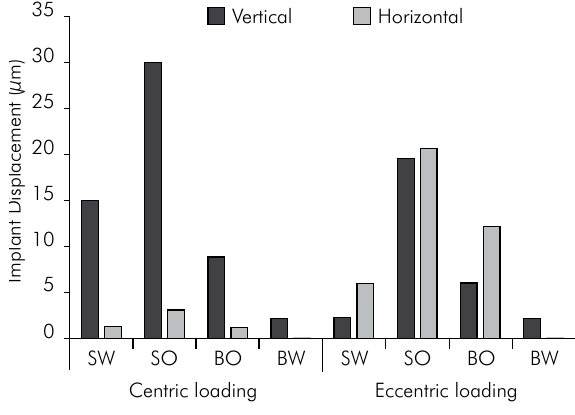
Figure 4. Vertical and horizontal implant displacement (µm) during centric and eccentric loading simulations.